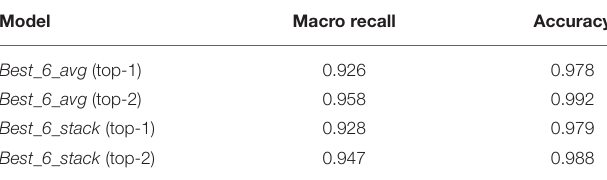
TABLE 2 | Top-1 and top-2 recall and accuracy.